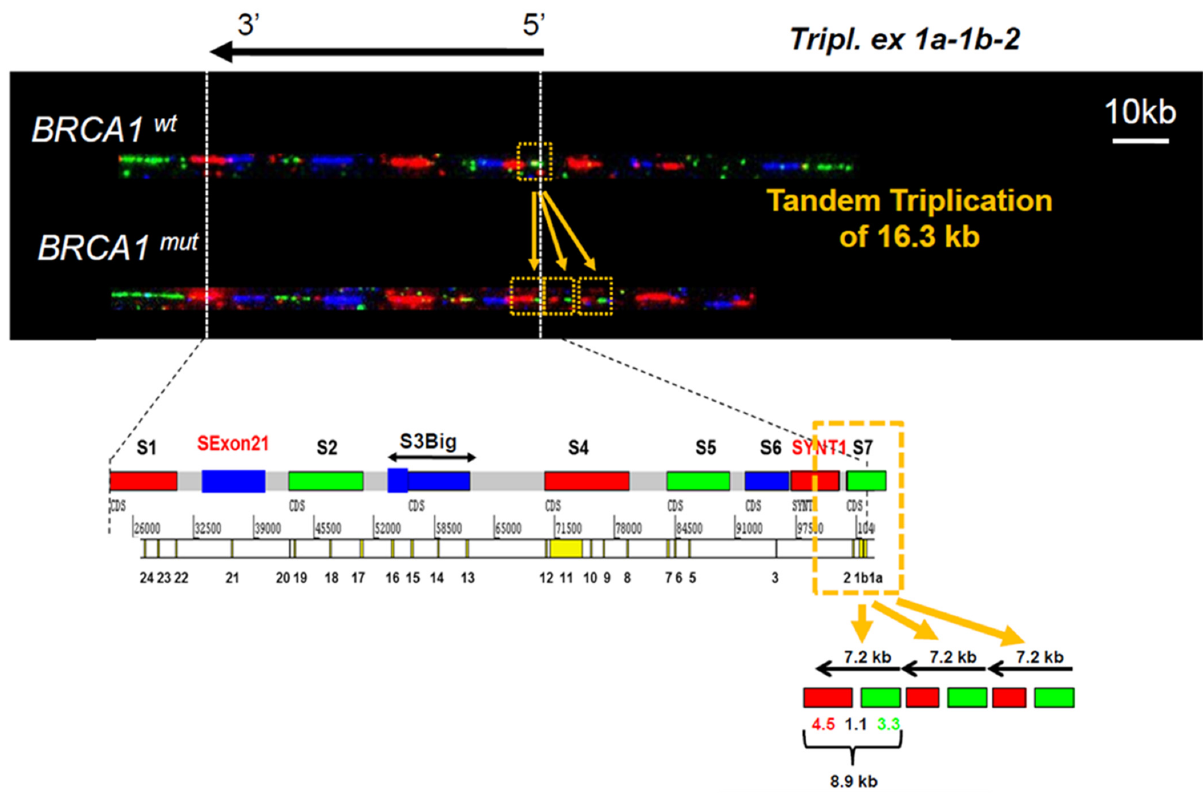
Figure 3. Molecular combing analysis of BRCA1 5 ′ region. Molecular combing was performed using high-resolution BRCA1 Genomic Morse Codes, as previously published [32]. The complete BRCA1 GMC covers a genomic region of 200 kb and is composed of 9 probes (S1–S7) of a distinct color (green, red, or blue). Triplication of exons 1 and 2 and part of the intron 2 of BRCA1 gene is visible as a tandem repeat triplication of the red and green signal of S7 and SYNT1 probes. Data are representative of the analyses performed on DNA from families F15, F16, F17, and F18. The sizes are estimated with this technology and are not defined precisely contrary to Sanger sequencing.